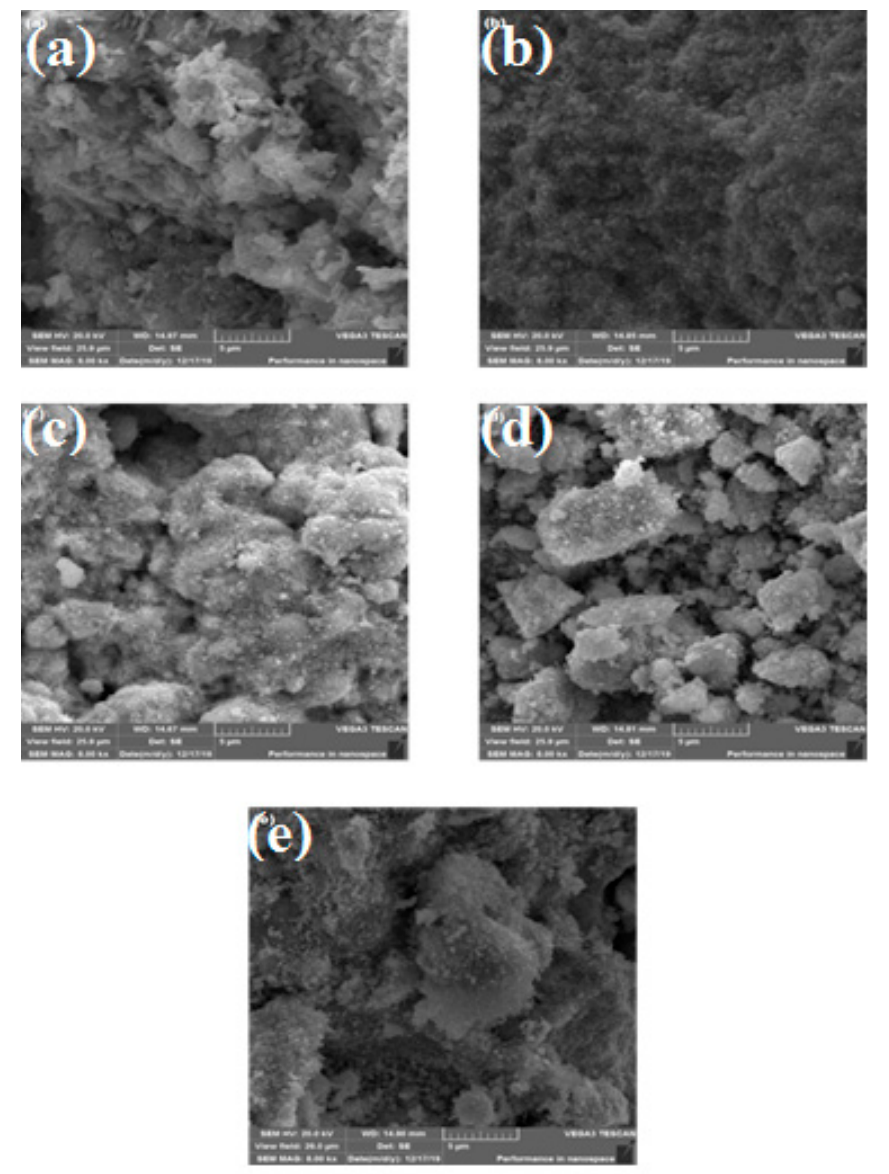
Figure 2. SEM images of ( a ) Zr1CrO 2 , ( b ) Zr3CrO 2 , ( c ) Zr5CrO 2 , ( d ) Zr7CrO 2 , and ( e ) Zr9CrO 2 pho ‐ tocatalysts.